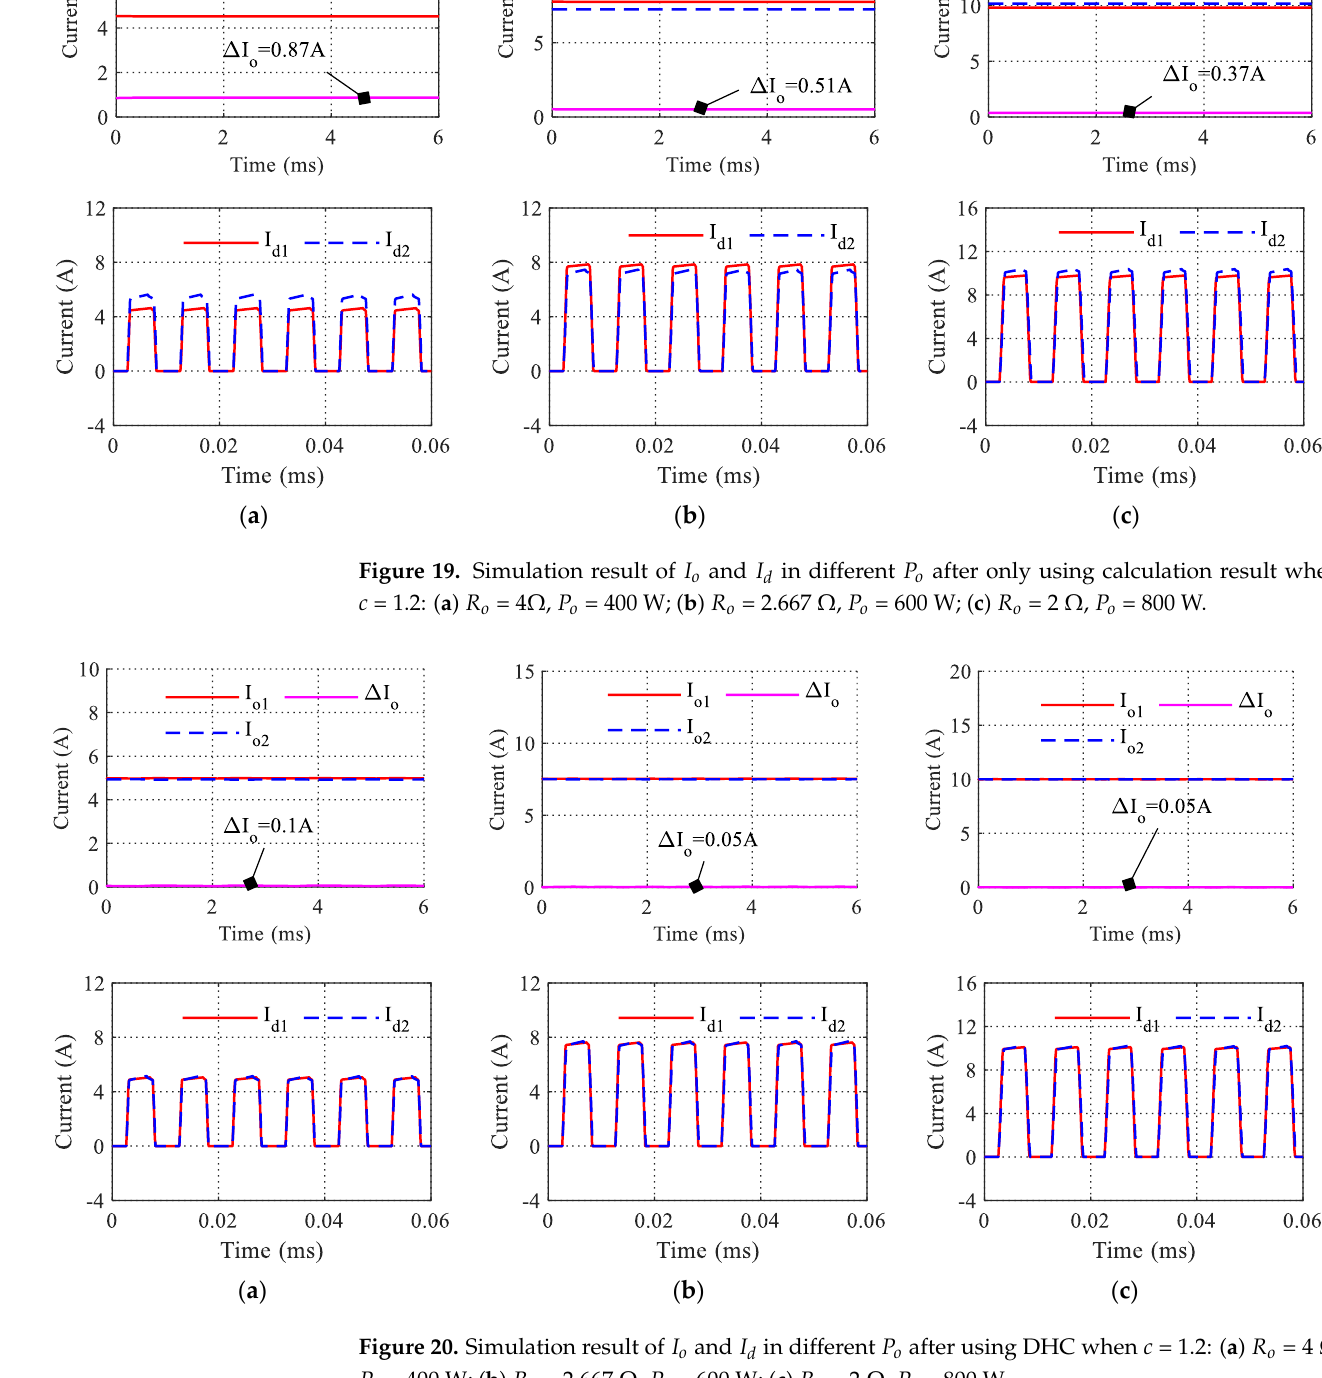
P o = 400 W; ( b ) R o = 2.667 Ω , P o = 600 W; ( c ) R o = 2 Ω , P o = 800